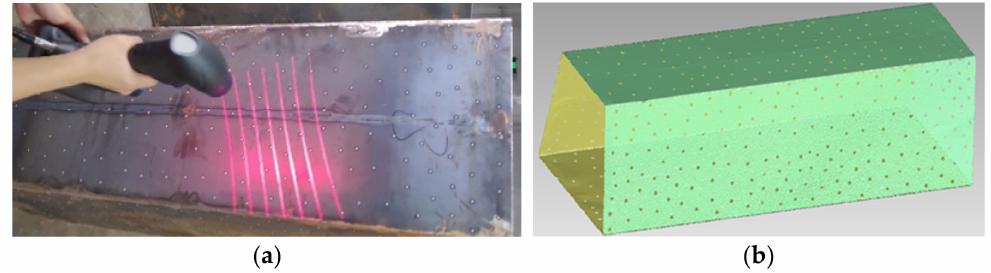
Figure 6. Three-dimensional scanning ( a ) Three-dimensional scanning with laser scanner ( b ) Three- dimension scanning point cloud